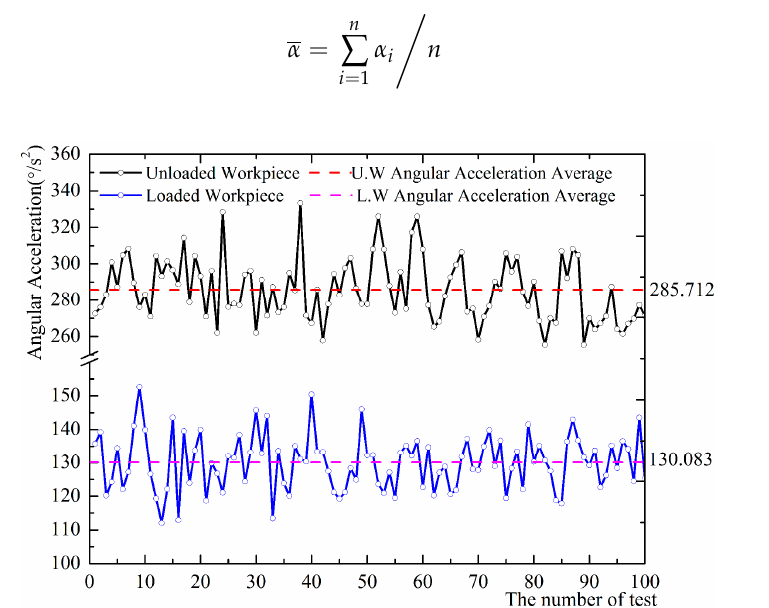
Figure 7. Angular acceleration in different states.